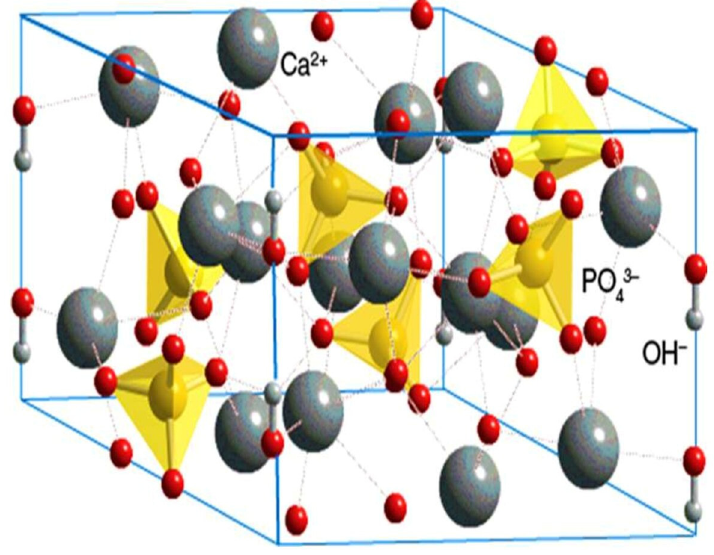
Figure 1. Schematic hexagonal structure of the hydroxyapatite, Ca = calcium; PO 43 − = phosphate; OH = hydroxyl [19] .